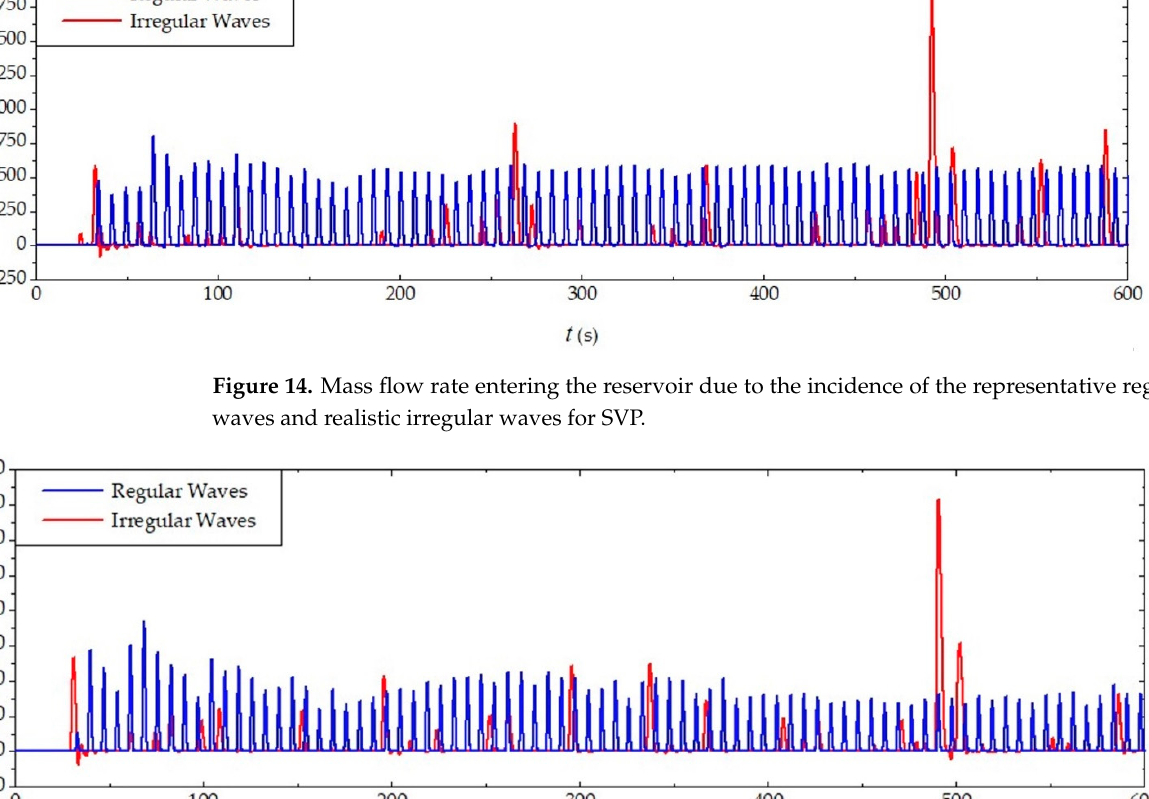
Figure 13. Mass flow rate entering the reservoir due to the incidence of the representative regular waves and realistic irregular waves for RG.